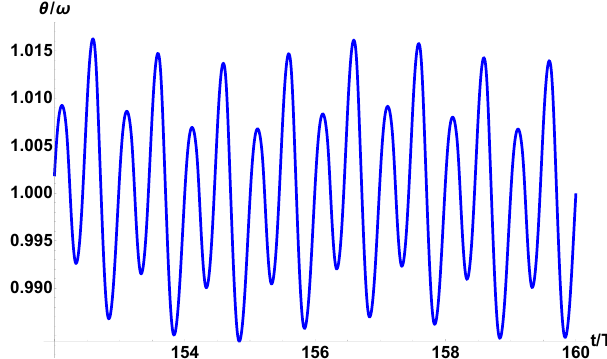
Fig. 6. The ratio between angular velocity and wave frequency for asymmetric rotor in monochromatic waves.